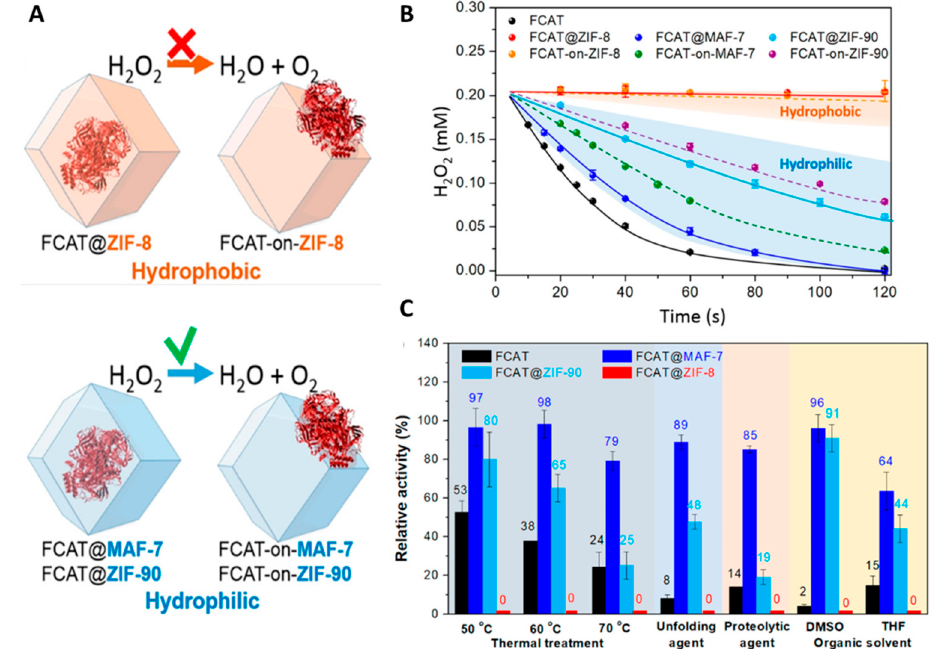
Figure 6. ( A ) MOFs with varying degrees of hydrophobicity on catalase immobilization on MAF-7, ZIF-90, and ZIF-8 by post synthesis or one-pot methods. ( B ) Activity data for catalase immobilization on MAF-7, ZIF-90, and ZIF-8 by post synthesis or one-pot methods compared with the free enzyme. ( C ) Activity of biocatalysts after thermal treatment, in the presence of chaotropic agent (urea), in the presence of proteolytic agent (4 mg mL -1 protease, 2 h), or after exposure to organic solvent (DMSO or tetrahydrofuran (THF), 2 h). Figure adapted with permission from [43]. Copyright 2019 American Chemical Society.